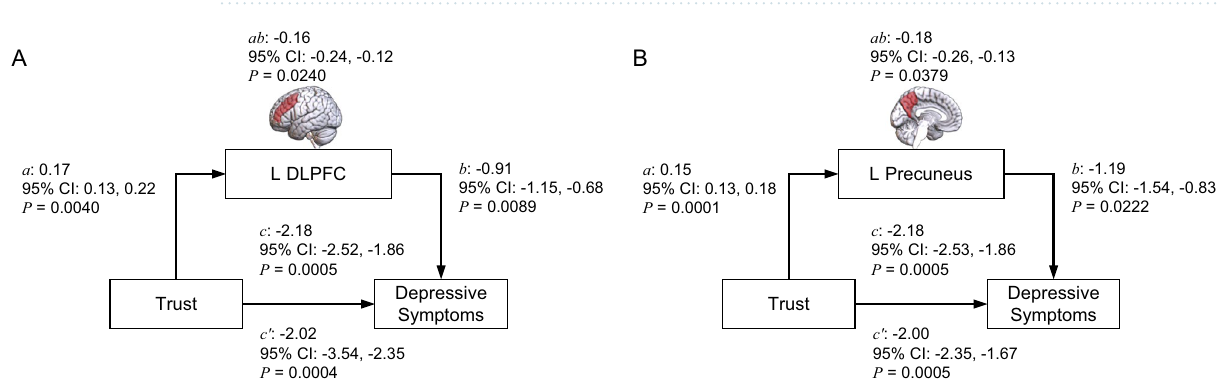
Figure 3. Whole-brain VBM analyses of trust and depressive symptoms. (A) Social brain regions with increased gray matter volume in high trusters relative to low trusters. Highlighted brain regions include the MFG, DMPFC, precuneus, posterior cingulate and angular gyrus. (B) Enlargement of social brain regions in healthy controls relative to MDD patients in the Hiroshima sample. Both analyses were performed using a non- parametric permutation method and a statistical threshold of P FWE < 0.05, family-wise error corrected for the whole-brain.